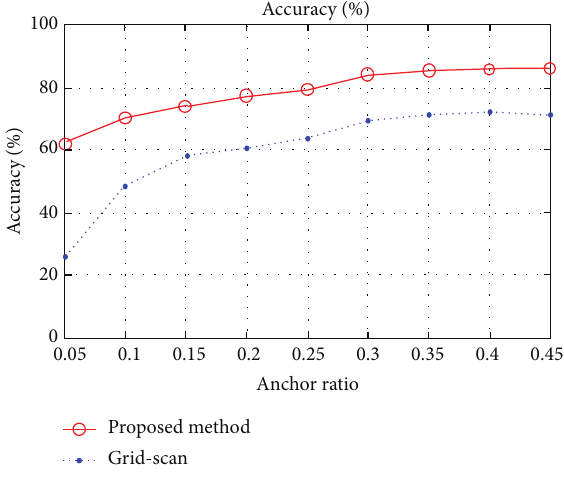
Figure 4: Anchor ratio versus accuracy